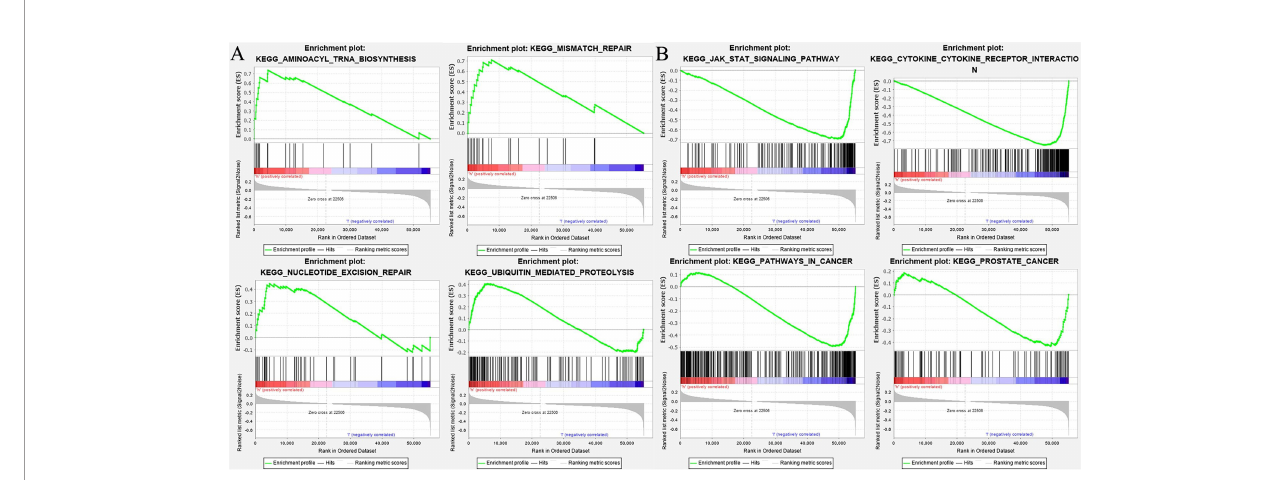
FIGURE 5 | (A) The biological function enrichment analysis of lactoferrin (LTF) was performed by gene set enrichment analysis (GSEA) software, and Kyoto Encyclopedia of Genes and Genomes (KEGG) results showed that the high expression of LTF mainly promoted a variety of biological pathways, such as aminoacyl tRNA biosynthesis, mismatch repair, ubiquitin-mediated proteolysis, and nucleotide excision repair. (B) The biological function enrichment analysis of LTF was carried out by GSEA software. KEGG results showed that the high expression of LTF was related to the inhibition of biological pathways such as the Janus kinase (JAK)/ signal transducer and activator of transcription 3 (STAT) signal pathway, tumor pathway, and prostate cancer progression